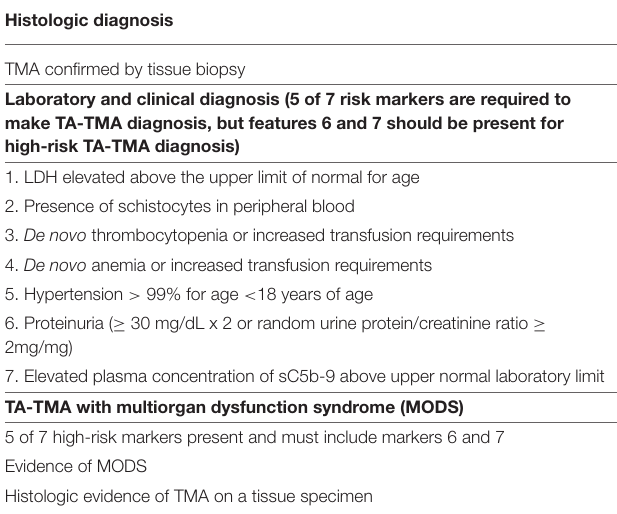
TABLE 1 | Diagnostic criteria for high-risk TA-TMA proposed by Jodele et al. (2). Histologic